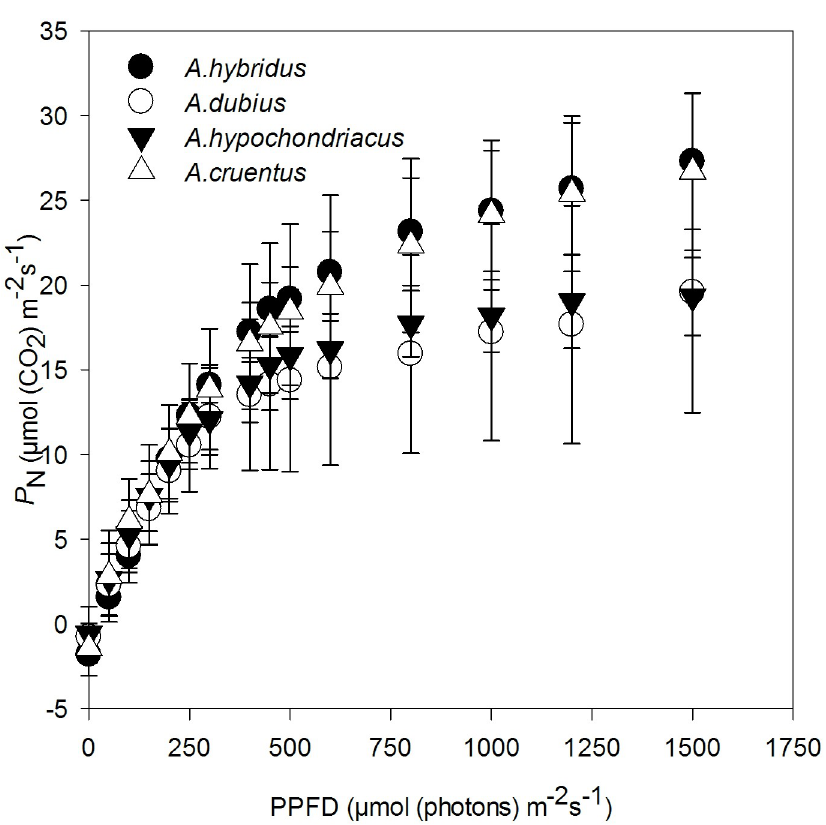
Fig 2. The response of net photosynthetic rate, P N , to photosynthetic photon flux density (PPFD) on new fully expanded leaves of four amaranth species. The symbols for each species represent the mean pooled data of six light response curves ( n = 6, two from each of the three measurement dates) since there was no measurement date effect on the light response curves. Lines joining the points were omitted for clarity. Bars represent ± SD. Measurement conditions were leaf temperature of 25˚C, CO 2 concentration of 400 μ mol mol -1 , average relative humidity of 60–70%, and a vapour pressure deficit of 1.3 ± 0.3